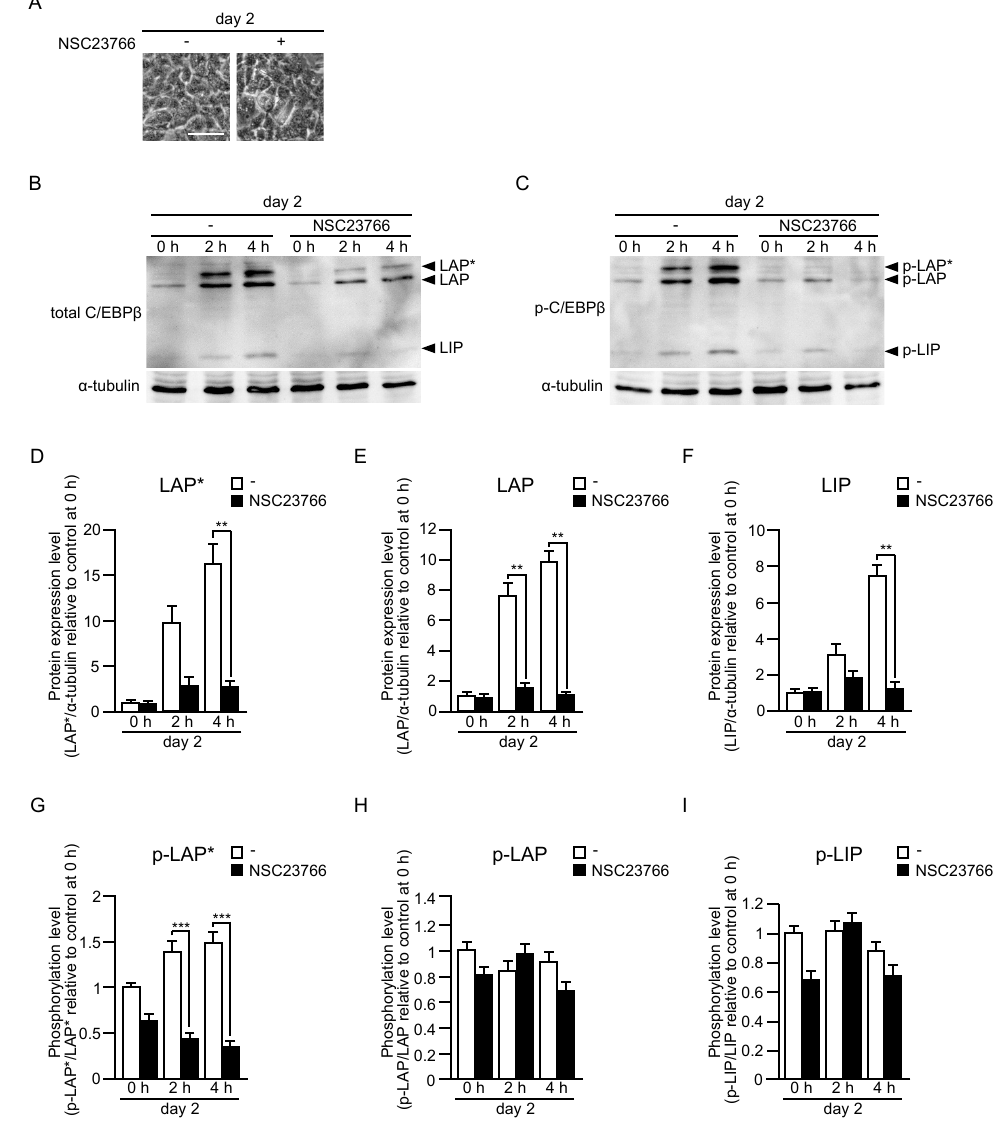
Figure 6. Protein and phosphorylation levels of three C/EBP β variants in the early stage of differen- tiation of adipose progenitor cells into adipocytes in vitro. ( A ) Phase-contrast images of cells derived from control mice in the presence or absence of NSC23766 at day 2. Scale bar, 50 µ m. Protein ( B ) and phosphorylation ( C ) levels of three C/EBP β variants (LAP*, LAP, and LIP) in cells derived from control mice in the presence or absence of NSC23766 were determined by immunoblot analysis using antibodies against C/EBP β ( B ) and phosphorylated C/EBP β ( C ), respectively. α -tubulin served as a loading control. Intensities of bands for LAP* ( D ), LAP ( E ), LIP ( F ), p-LAP* ( G ), p-LAP ( H ), and p-LIP ( I ) in immunoblots were quantified. Data are shown as means ± S.E. ( n = 3). ** p < 0.01, *** p < 0.001 (Student’s t